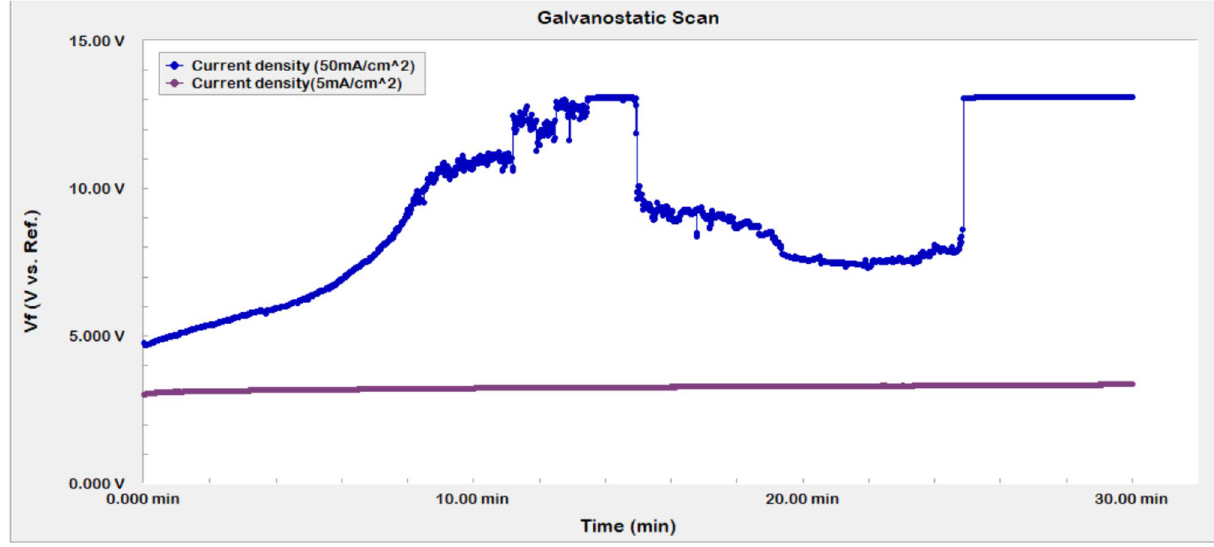
Figure 10. Effect of current density on V(t) for pyrite in DTPAK 5 10 wt. % + K 2 CO 3 9 wt. %.